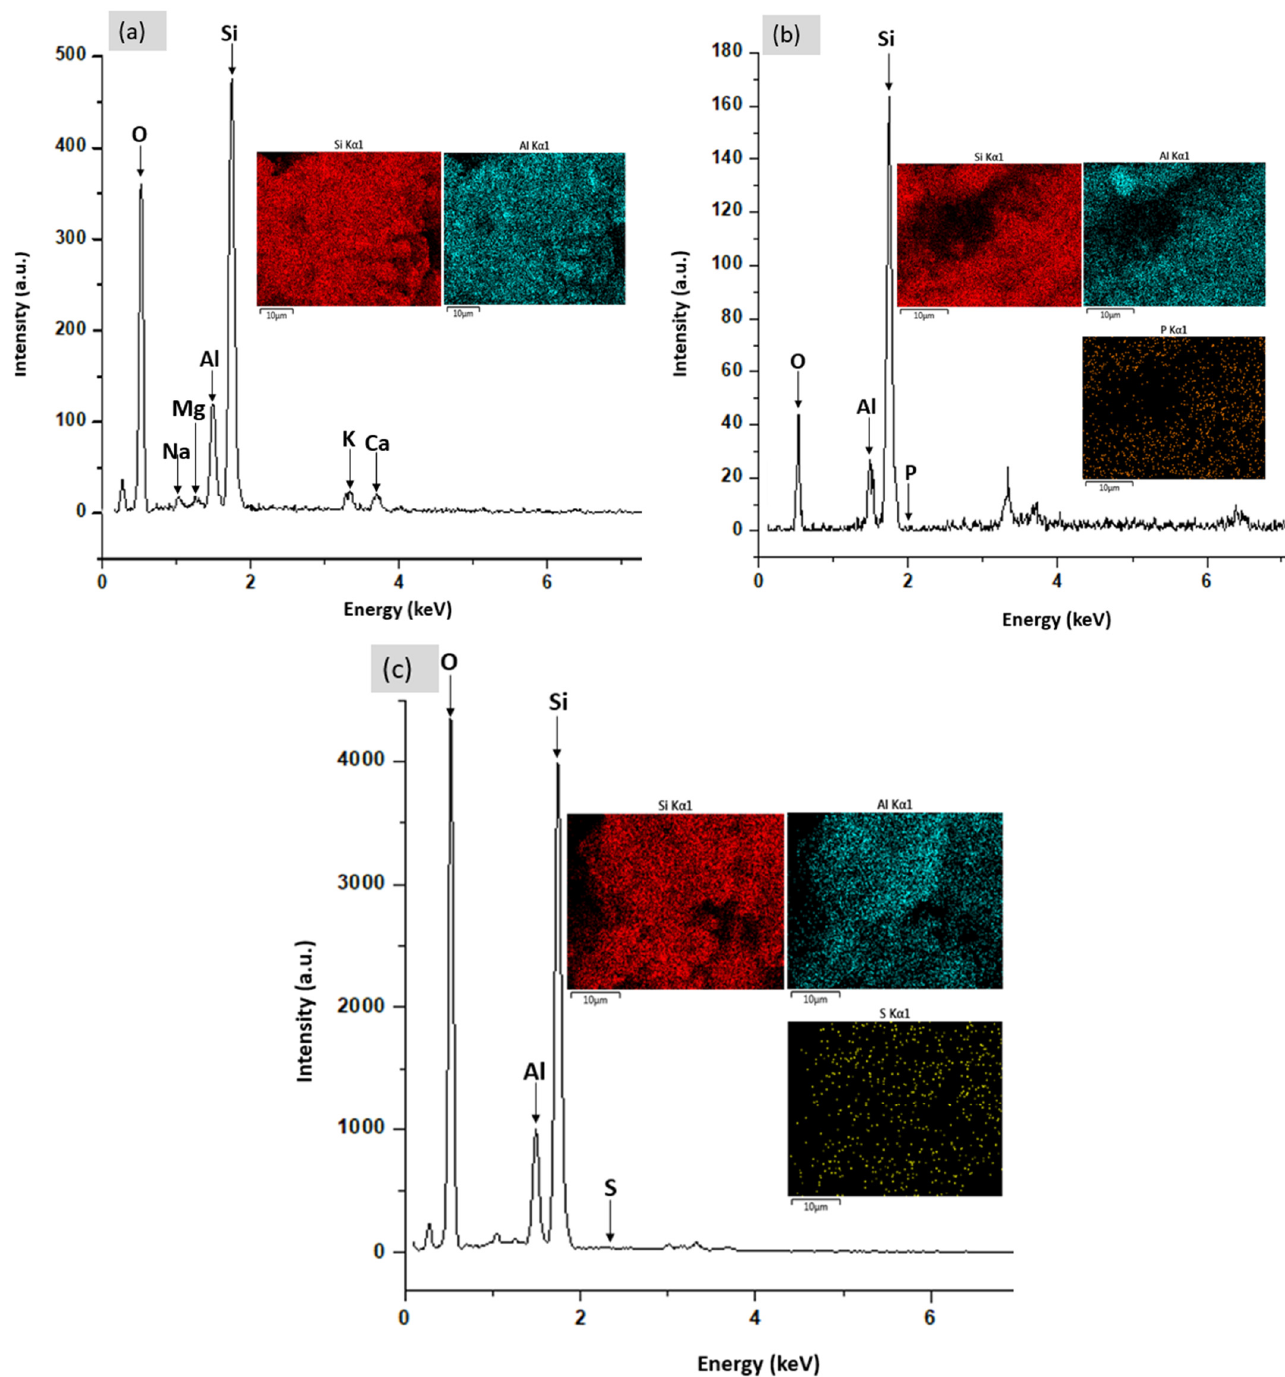
Figure 9. EDX analysis showing the EDX spectrum and dot mapping of ( a ) NZ, ( b ) PZ, and ( c )